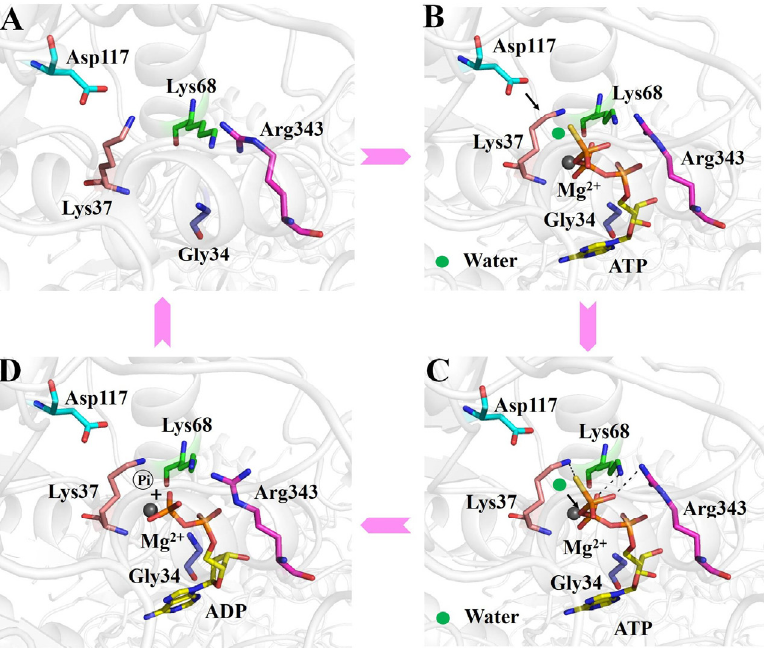
Figure 5. Working mechanism of the ATP binding and hydrolysis of RadD. ( A ) Active center of apo-RadD. ( B ) ATP enters into the active center, and polarization of the attacking water molecule by Asp117. ( C ) Nucleophilic attack, formation, and stabilization of the transition state. ( D ) The chemical bond between γ - and β -phosphoric acids is broken, and the intermediates further become the final products of ADP and phosphoric acid.